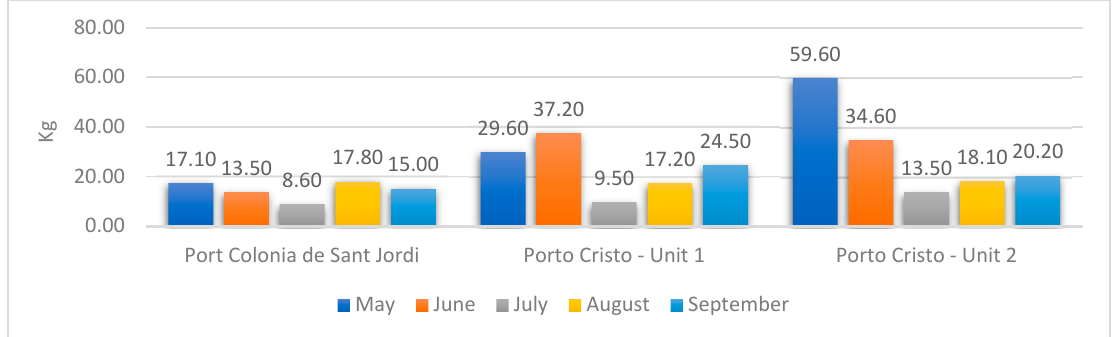
Figure 8. Weight of collected marine litter per month at each site [kg].